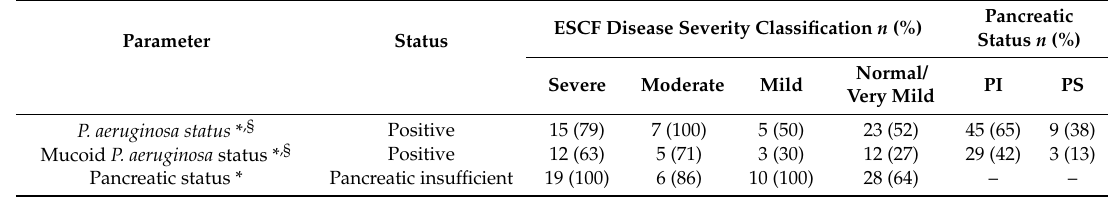
Table 2. Relationship of ESCF disease severity and clinical